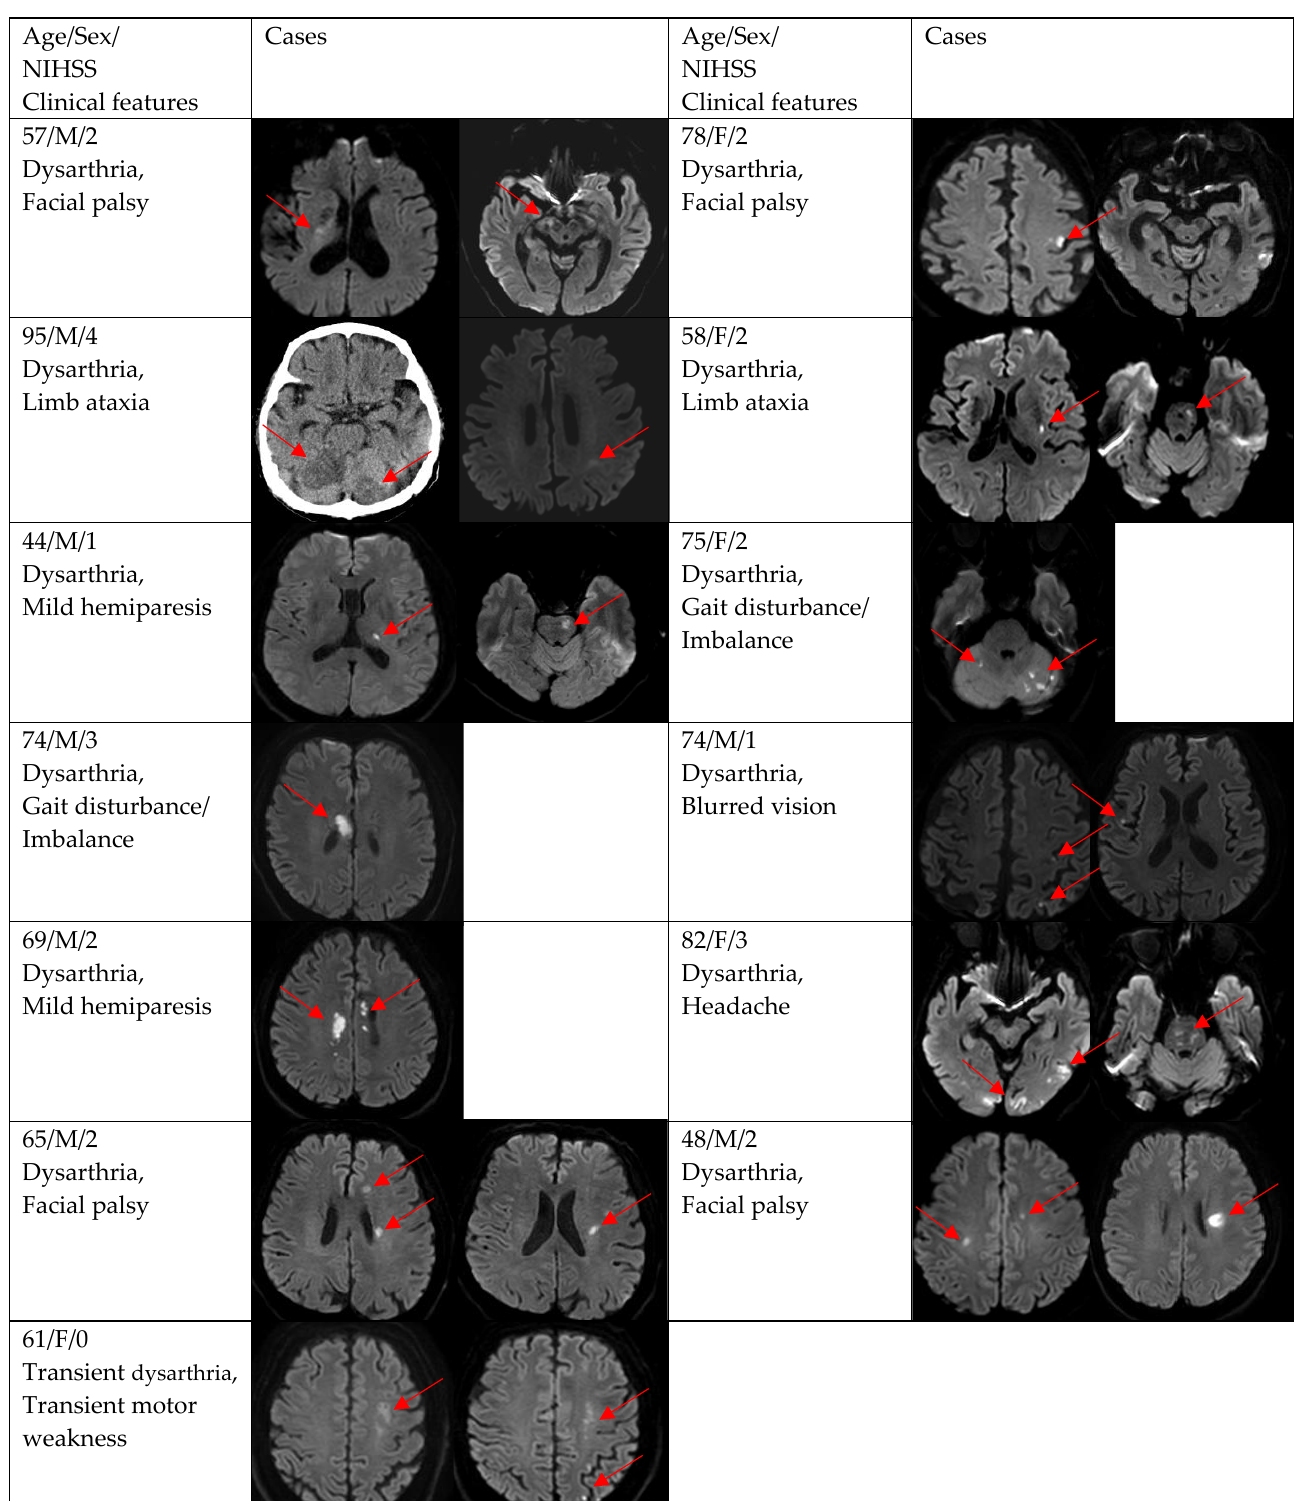
Figure 3. Clinical characteristics and neuroimaging findings of patients with ischemic stroke or TIA presenting with prominent dysarthria and small and single lesions.